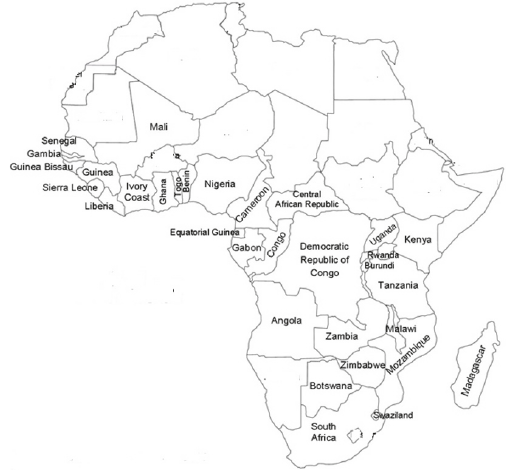
Figure 2: Distribution of Albizia adianthifolia in tropical Africa.